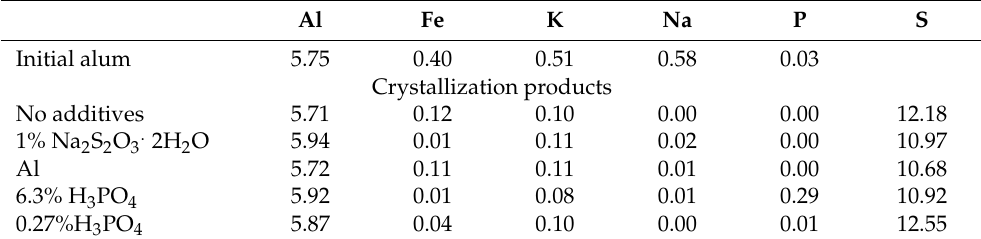
Table 4. Composition of alum (mass %) after the recrystallization experiments. Al Fe K